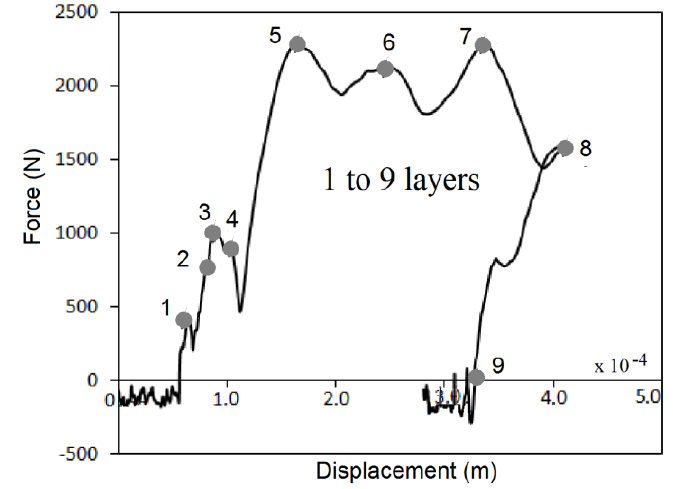
Figure 14. Comparison of the force vs. displacement diagram for an impact at 30 J in unmodified panel.